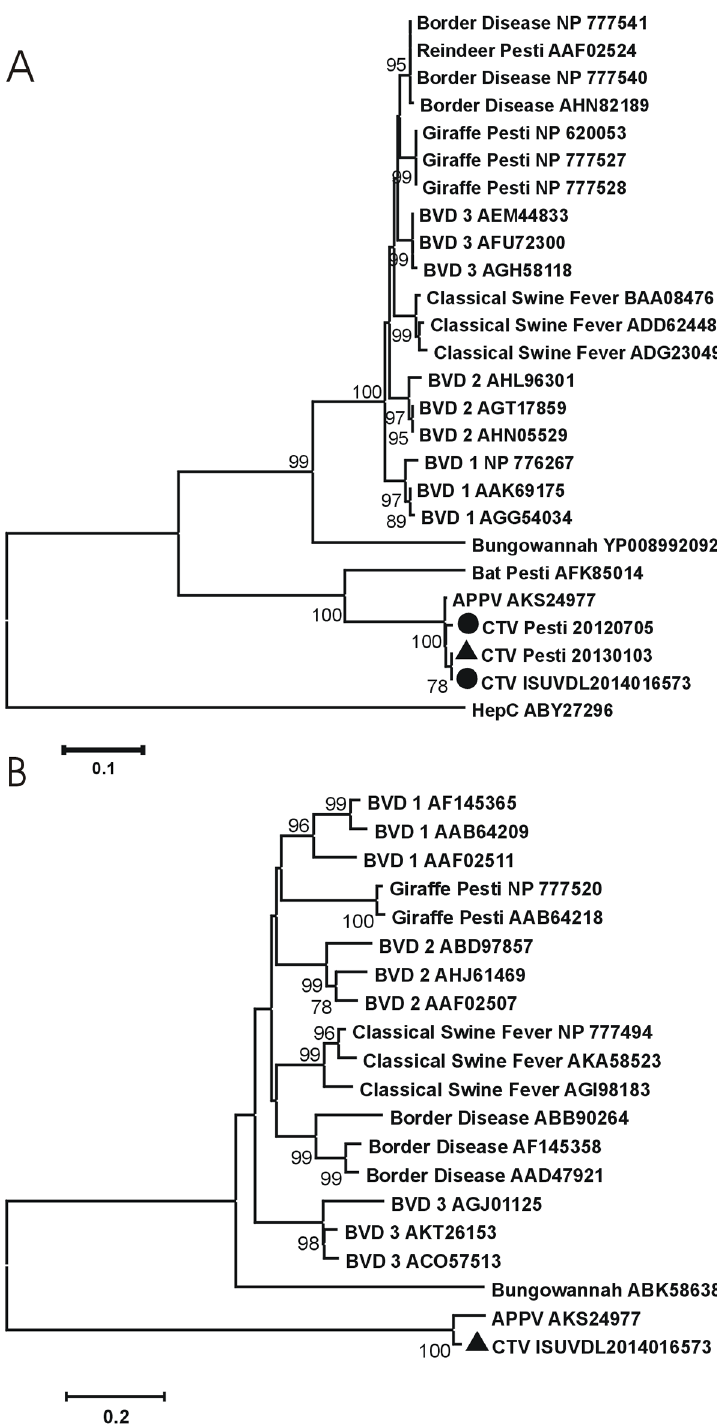
Fig 1. Phylogenetic association of pestiviruses. Neighbor-joining phylogenetic trees generated with 1,000 bootstrap samplings (MEGA 6.0) for pestivirus NS3 (A) and Npro (B) amino acids aligned by ClustalW multiple alignment. GenBank accession numbers for each sample indicated in name. Circles indicate sequences described from this study and triangle indicates the sequence from the virus described in this study used for